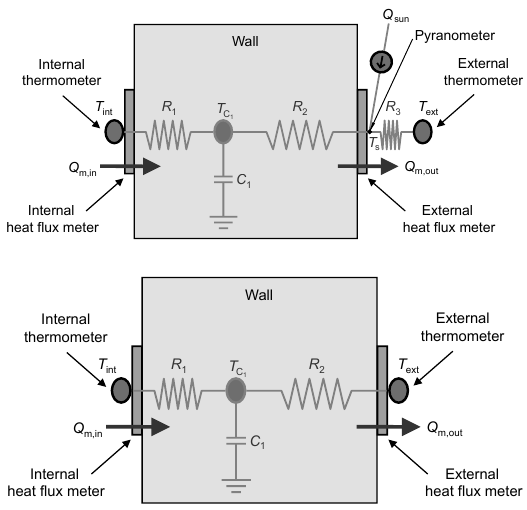
Figure 2. One thermal mass (1TM) model with ( top ) and without ( bottom ) the explicit incorporation of solar radiation as source of heat in the system. The diagram shows the equivalent electrical circuit modelling the heat transfer and the monitoring equipment; when explicitly accounting for solar radiation, T s represents the surface temperature of the element. Parameters of the model are the effective thermal mass ( C 1 ) and its initial temperature resistances ( R 1 , R 2 , R 3 ) . Measured quantities are the internal ( T int ) and external ( T ext ) temperatures, the heat fluxes entering the internal ( Q m,in ) and leaving the external ( Q m,out ) surfaces, and the incident solar radiation ( Q sun )